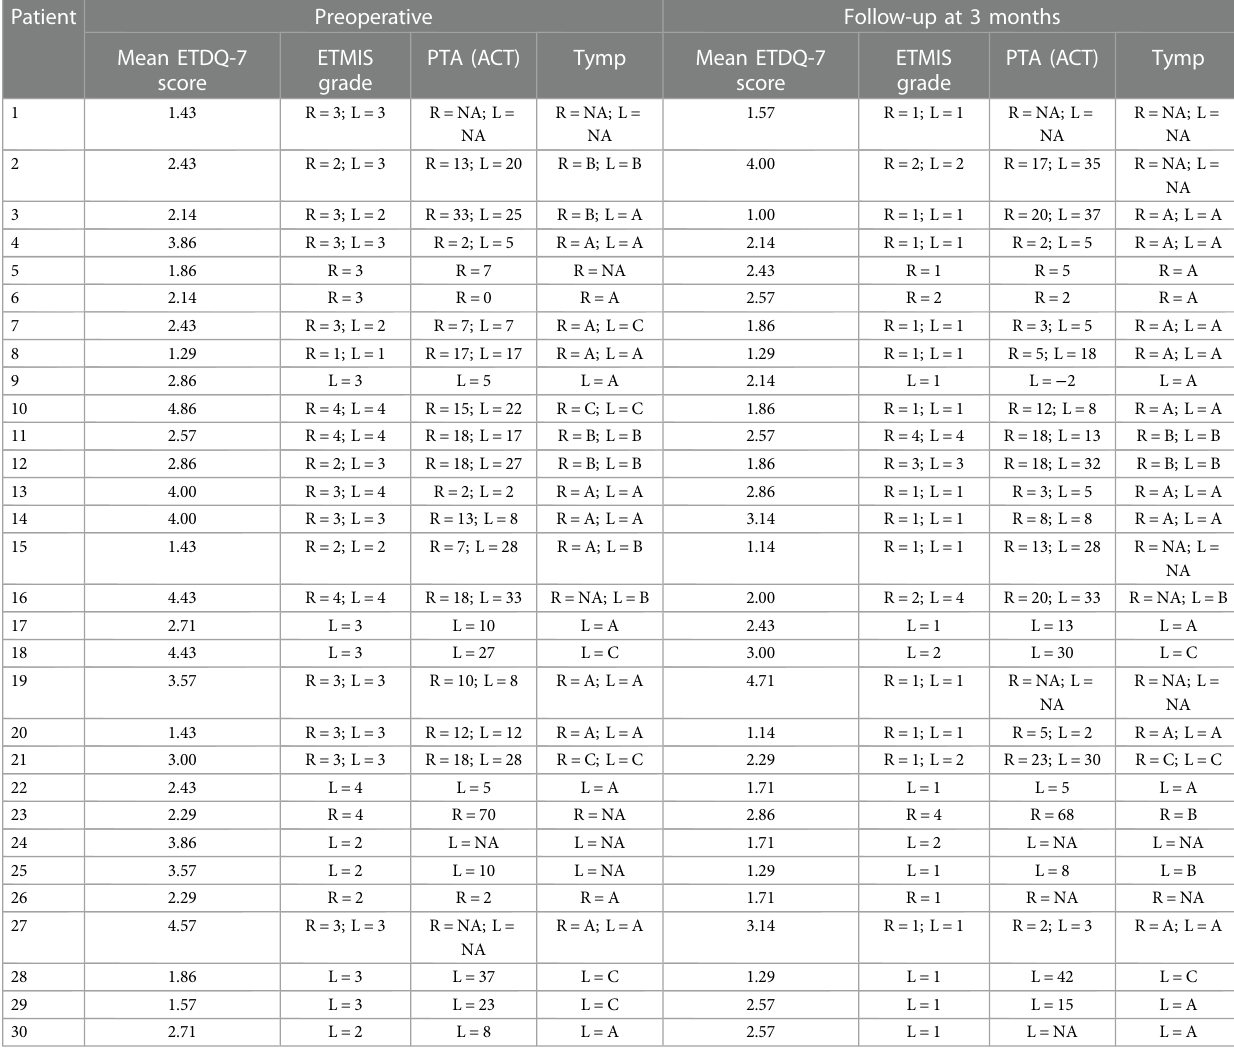
TABLE 2 Individual patients ’ mean ETDQ-7 score and ETMIS grade preoperatively and at a 3-month follow-up.